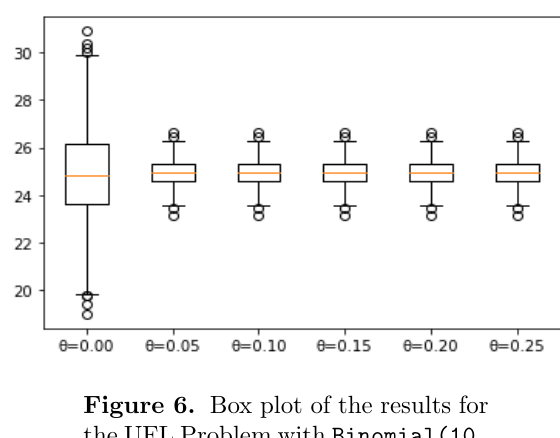
Figure 5. Box plot of the results for the UFL Problem with Uniform(0, 10) and R = 100.